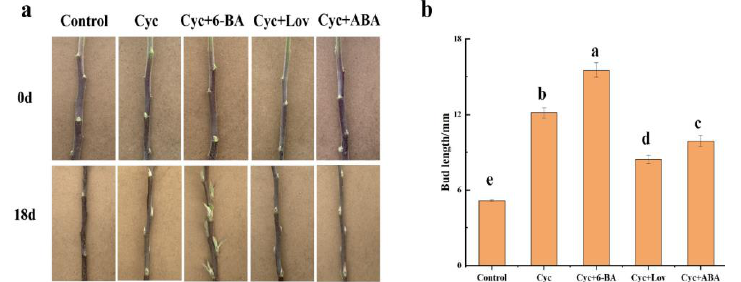
Figure 8. The phenotype and bud length of different pharmacologic treatments. ( a ) The phenotype of different pharmacologic treatments, Scale bar = 5.0 cm. 6-BA (6-benzylaminopurine, a kind of cytokinin). Lov, lovastatin (a synthetic inhibitor of CTK biosynthesis). ABA (abscisic acid). CYC (cyclanilide). ( b ) The bud length of different pharmacologic treatments. Data represent the mean ± SD ( n = 12). Bars with different letters are significantly different at α = 0.05